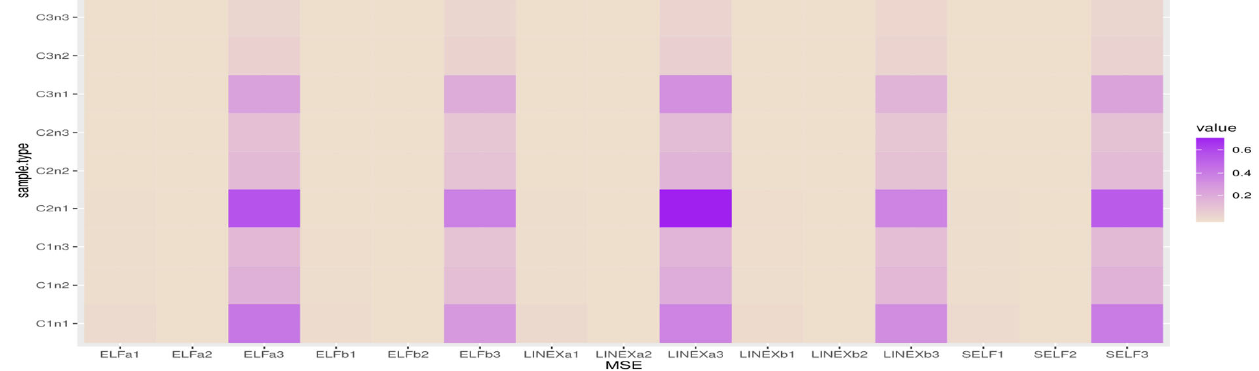
Figure 4. Heatmap for MSE when 𝑎 (cid:3404) 0.5, 𝑏 (cid:3404) 0.6 .